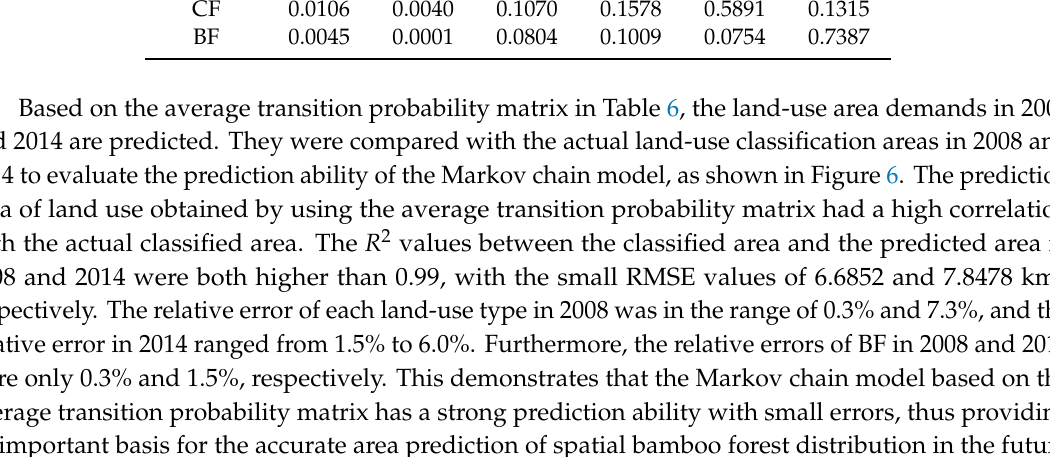
Figure 7. ( A ) The mean square error (MSE) of BPNN, ( B ) the accuracy of BPNN, and ( C ) the receiver operating characteristic (ROC) curves and area under ROC curve (AUC) values of BPNN. Figure 7C shows the receiver operating characteristic (ROC) curves and the area under ROC curve (AUC) values of the six land-use types obtained after the BPNN training. The ROC curve is used to prove the performance of a binary classifier system by changing the discriminative threshold, which directly reflects the true positive rate (TPR, specificity) and the false positive rate (FPR, sensitivity) of the model at different thresholds. The ROC curve defines FPR and TPR as the x and y axes, respectively, to reflect the comparison between specificity and sensitivity. Since the ROC curve